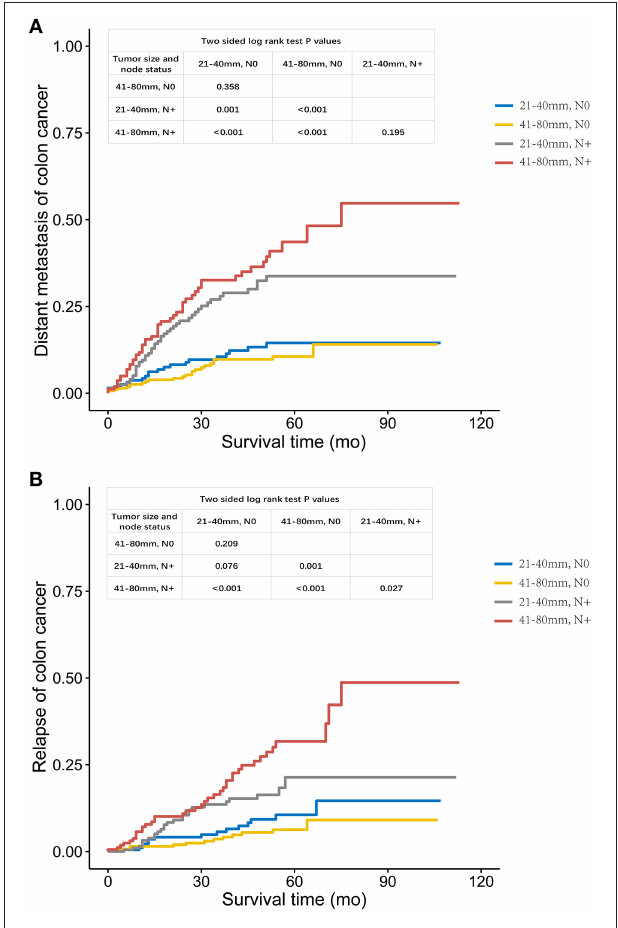
FIGURE 3 | (A) . Distant metastasis and (B) . Relapse curves using the Kaplan-Meier method in FUSCC cohort.